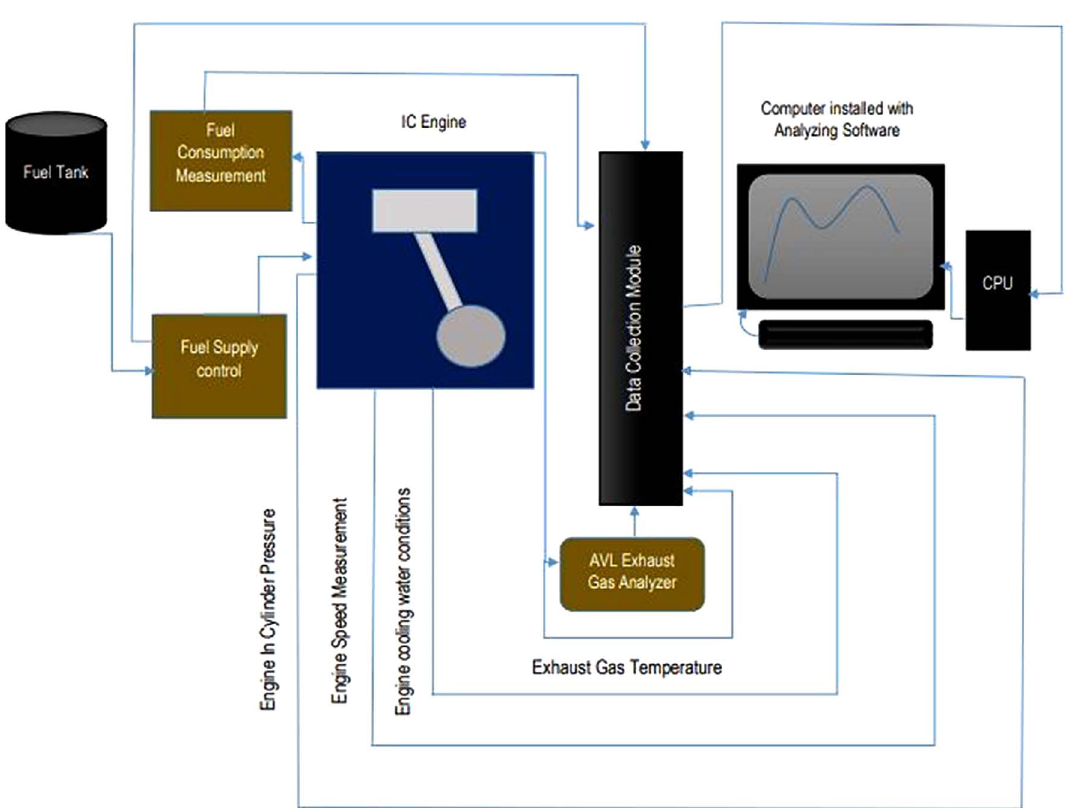
Fig. 2. Components description of the test engine